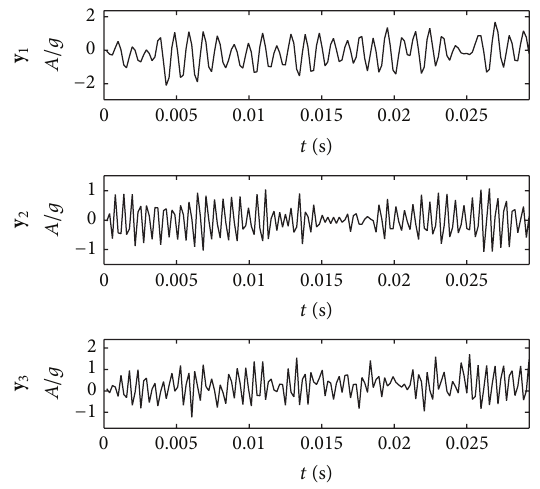
Figure 6: Waveforms of the mixed signals.